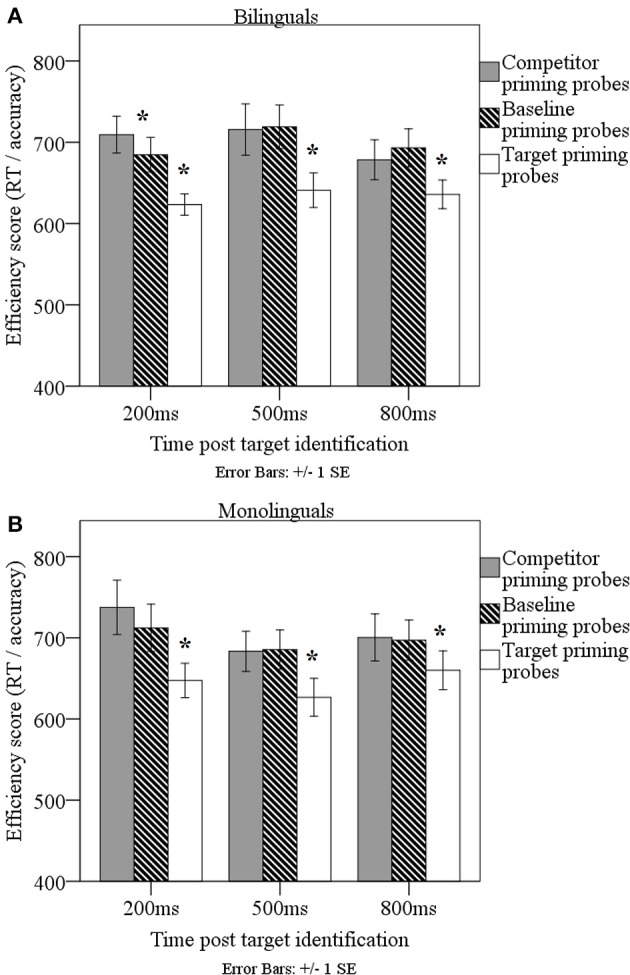
Responses as efficiency scores (ms/proportion correct) to competitor priming probes (gray) and target priming probes (white), relative to baseline priming probes (striped), in bilinguals (A) relative to monolinguals (B). *p < 0.01.